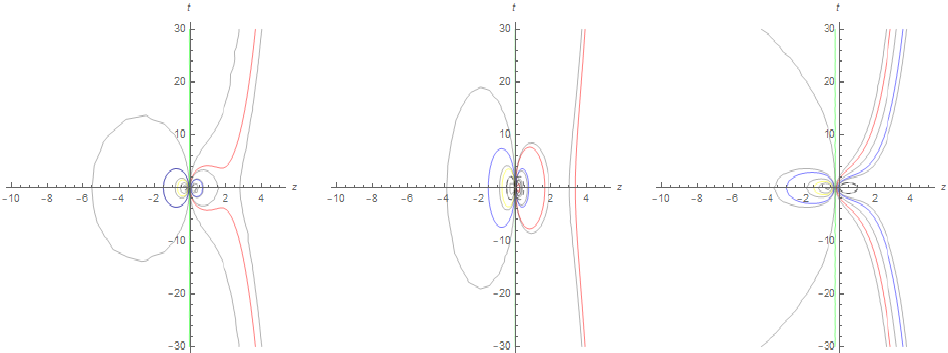
Figure 4. Contour displays for Figure